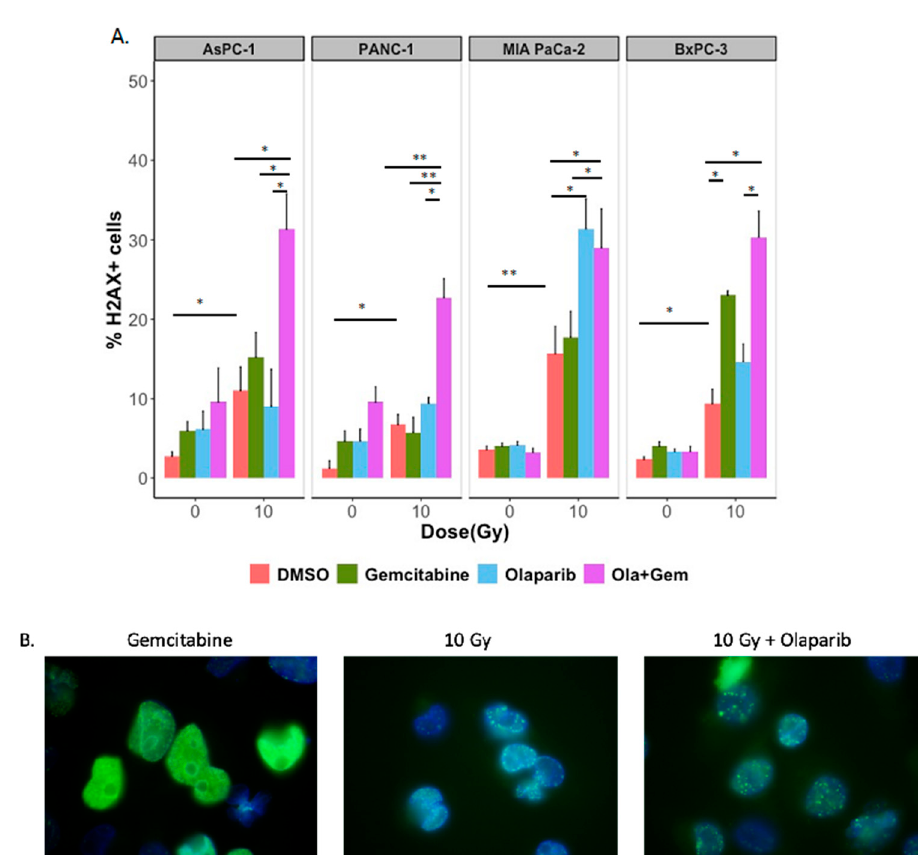
Figure 6. ( A ). Effect of irradiation (10 Gy), olaparib (1 µM) and gemcitabine (10 nM) on the amount of γ -H2AX positive cells, 24 h after treatment on AsPC-1, PANC-1, MIA PaCa-2 and BxPC-3 cell lines. Cells were labelled 24 h after treatment with anti- γ -H2AX antibody and analyzed for γ -H2AX positivity and DNA content using flow cytometry. Data shown are the mean percentage of γ -H2AX positive cells from 4 independent experiments. Statistical significance is indicated: p < 0.05 (*), p < 0.01 (**). ( B ) Typical patterns of γ -H2AX staining observed after treatment with gemcitabine, olaparib and 10 Gy irradiation after immunofluorescence analysis. Magnification 100x.